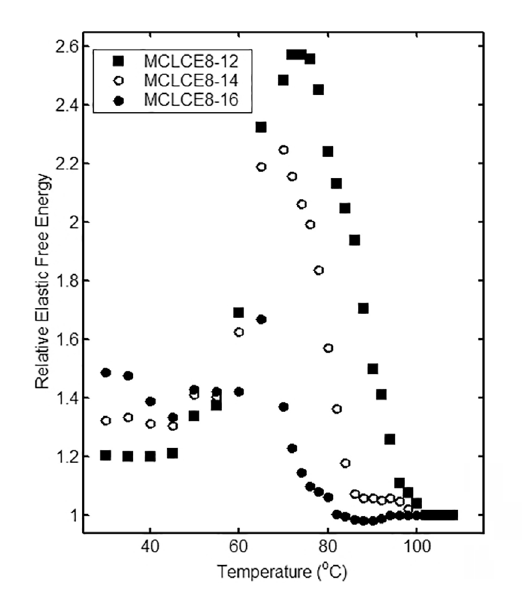
Figure 5. The graph of relative elastic free energy as a function of temperature for three MCLCE samples, with MCLCE-8 as a standard sample. MCLCE8-12, MCLCE8-14, and MCLCE8-16 are the names used to identify the relative elastic free energy of MCLCE-12, MCLCE-14, and MCLCE-16 relative to MCLCE-8. MCLCE8-12 has the highest relative elastic free energy, followed